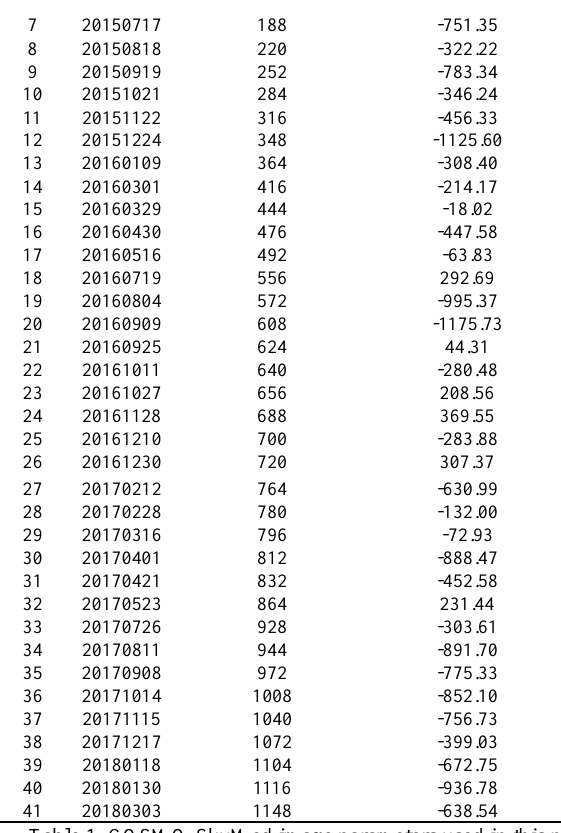
Table 1. COSMO-SkyMed image parameters used in this paper